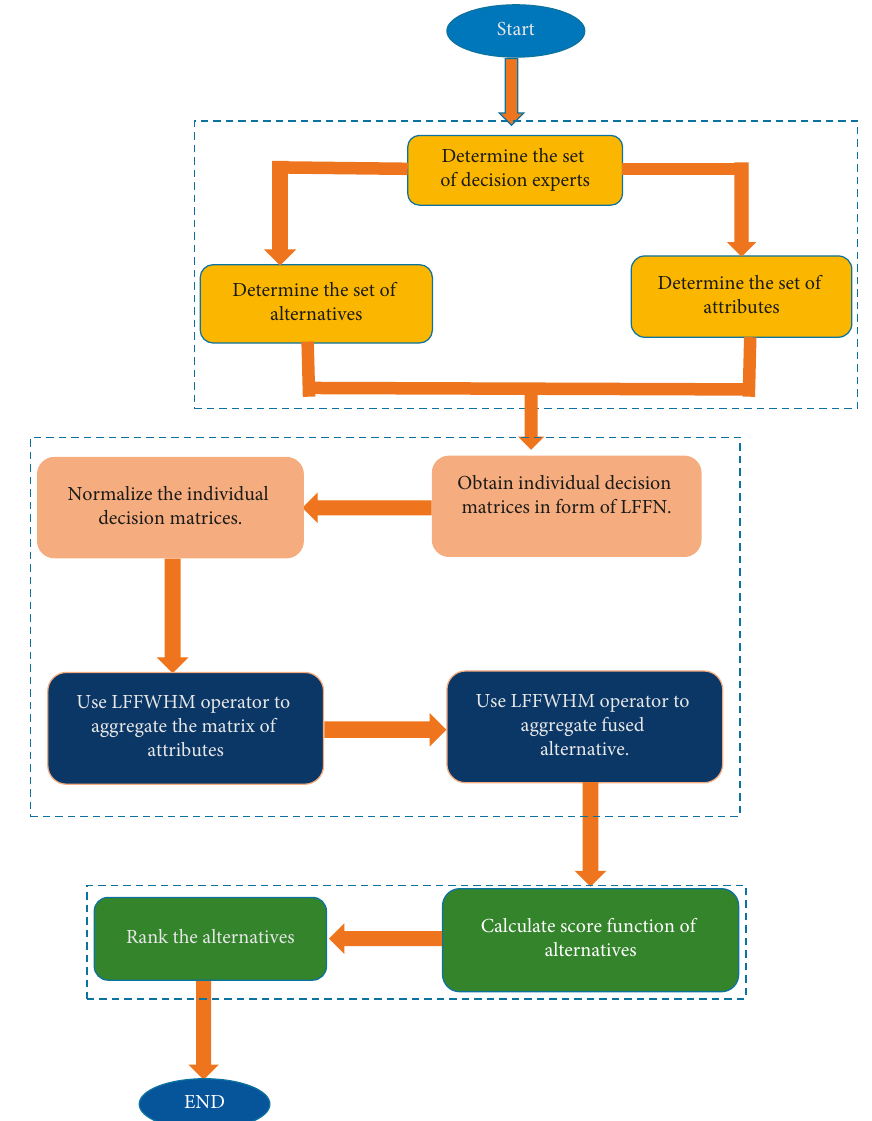
Figure 2: Flowchart of the proposed linguistic Fermatean fuzzy MAGDM method.